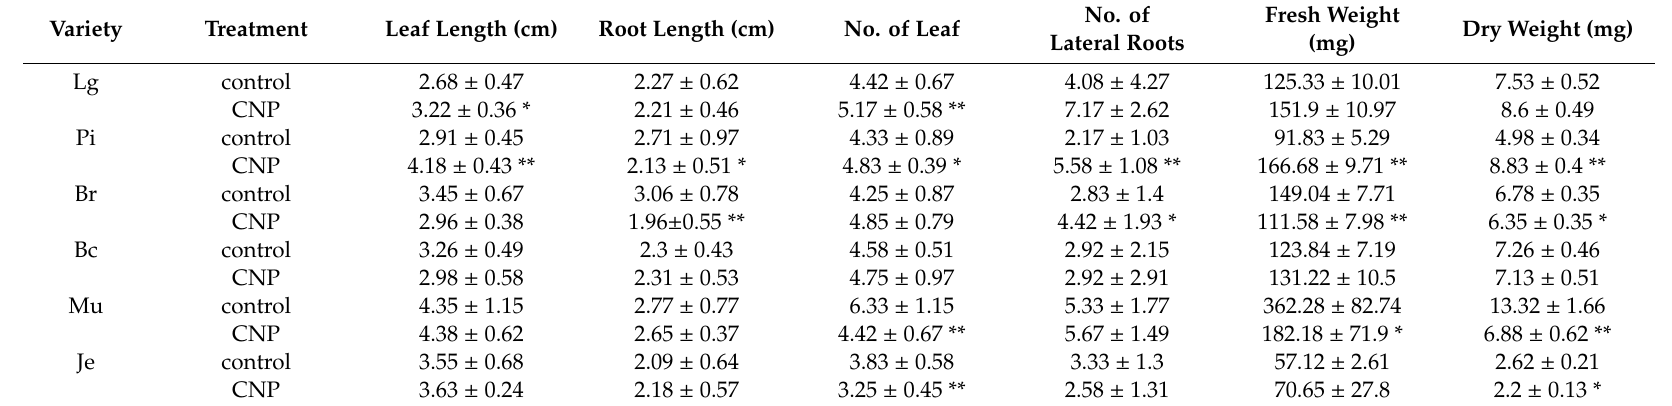
Table 2. E ff ects of carbon nanoparticle (CNP) pretreatment on post-germination growth of seedlings grown under salt